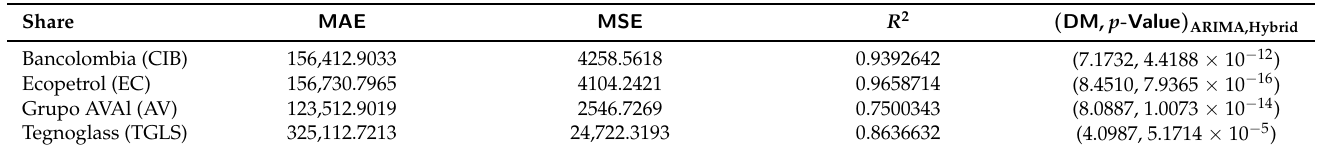
MAE and MSE ARIMA,Hybrid .